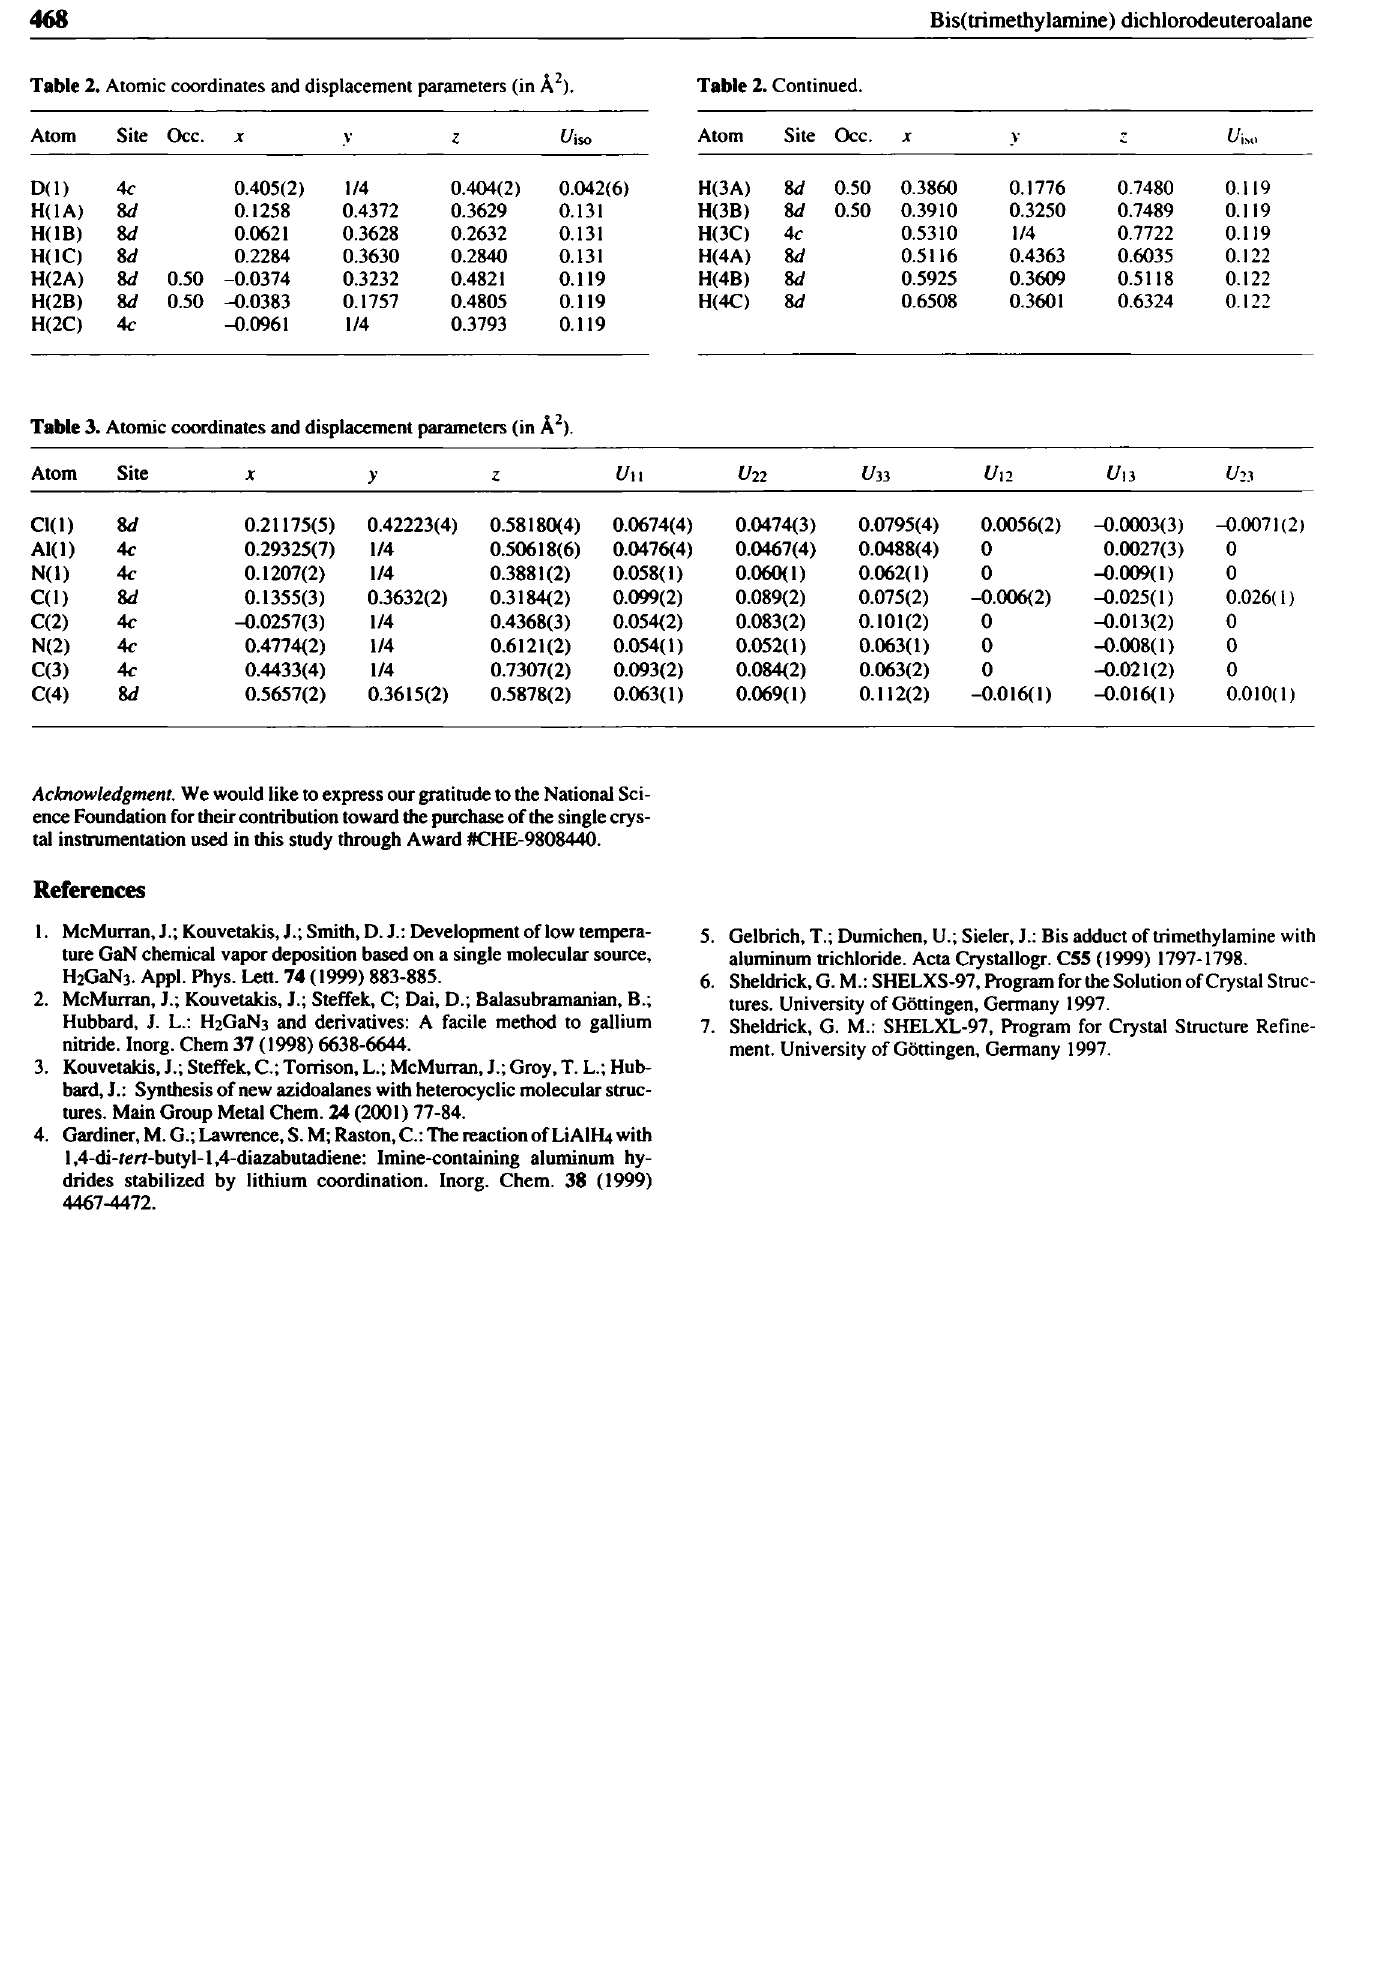
Table 2. Atomic coordinates and displacement parameters (in Ä 2 ).